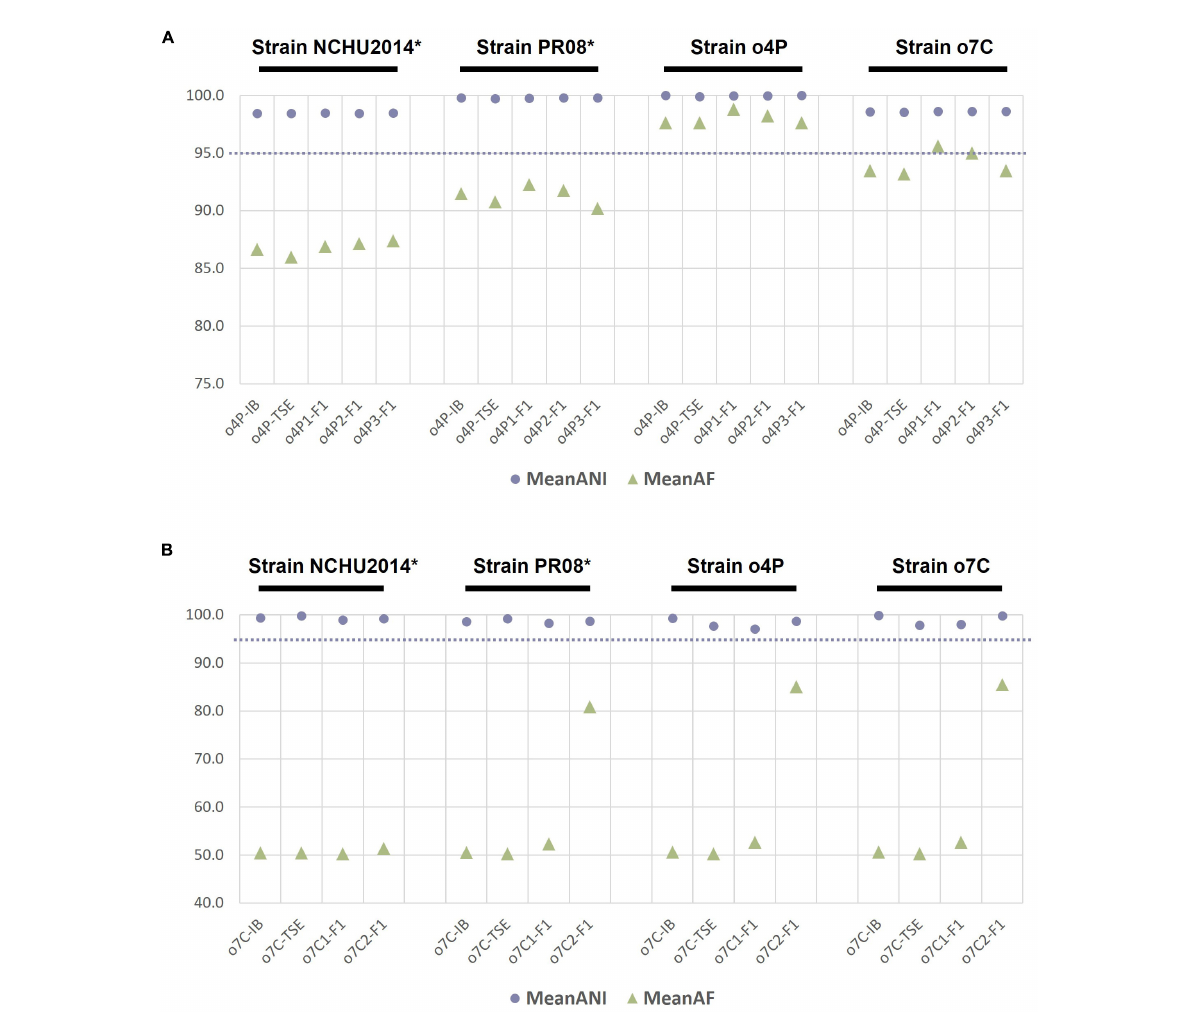
FIGURE2 Average nucleotide identity (ANI, %) and proportion of aligned genomic segments (AF,%) for down-sampled assemblies compared to the phytoplasma reference genomes assembled in this study and two publicly available phytoplasma reference genomes for (A) the infected potato host and (B) the infected capsicum host. The samples analyzed for each host included the unprocessed tissue homogenate (suffix “-IB”), differentially centrifuged pellet (suffix “-TSE”), and the iodixanol fraction with the highest percent of phytoplasma reads (suffix “-F1”). The phytoplasma genome used as the reference in each case is indicated above the graph in black font, with an asterisk indicating a complete genome. The dashed line indicates the proposed 95% ANI species delimitation threshold